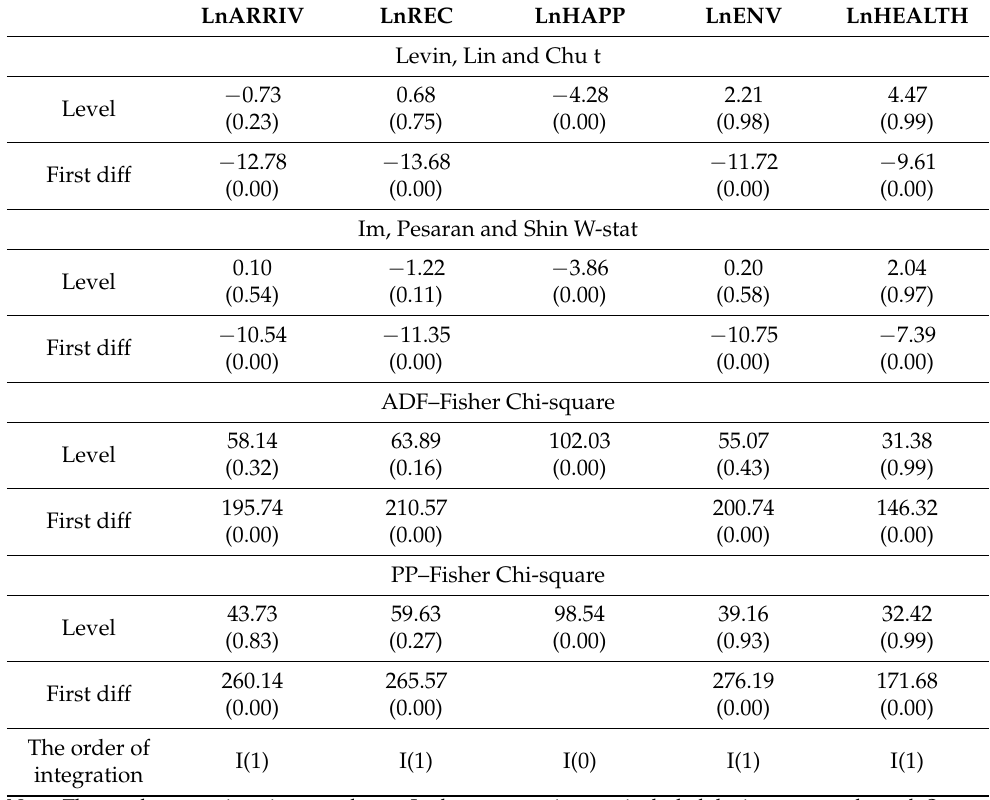
Table 4. Panel unit root